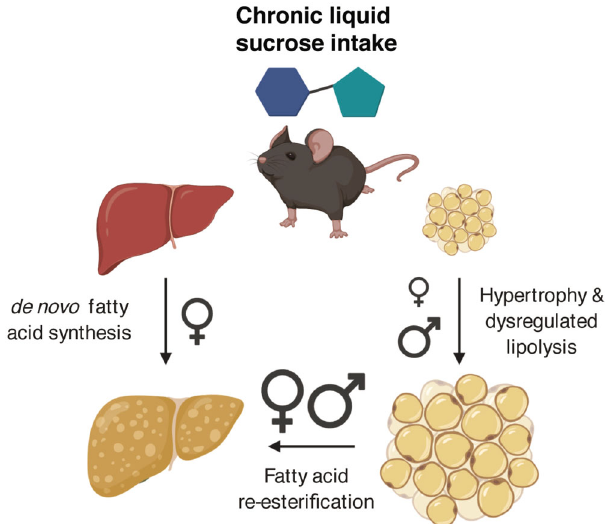
Fig.7|Summaryofmain fi ndings. Chronicliquidsucroseintakeatphysiologically relevant concentrations hassexually dimorphic effects on liverand adipose tissue, differences that likely contribute to the severity of the resultant steatosis. In this study,weobservedthatmalemicewereabletoconvertexcessdietarysucroseinto fatty acids that were readily stored as triglyceride in the adipose tissue, whereas female mice were unable to expand their adipose tissue as effectively as males, leading to additional manufacturing (and storage) of new fatty acids in the liver. Ourresultssuggestthatliquidsucroseintakeinducessteatosismainlyvia ‘ spillover ’ of fatty acids from dysregulated adipocyte lipolysis in both sexes, with additional contributions from de novo fatty acid synthesis occurring in females. Future stu- dies will identify the mechanisms responsible for these divergent responses and allow us to better target therapeutic strategies for the treatment of NAFLD. Image created with